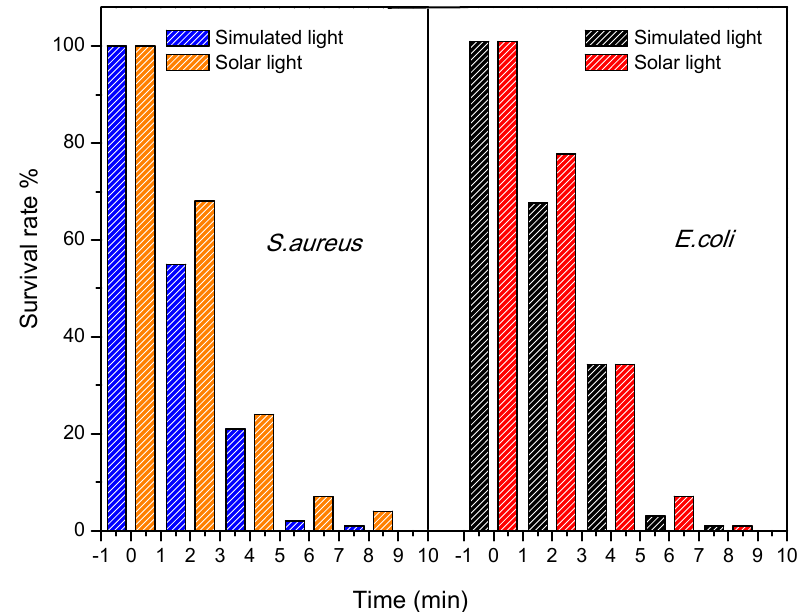
Figure 3. Survival rates of E.coli and S.aureus in the presence of Ag 9 (SiO 4 ) 2 NO 3 in simulated and sunlight, respectively.